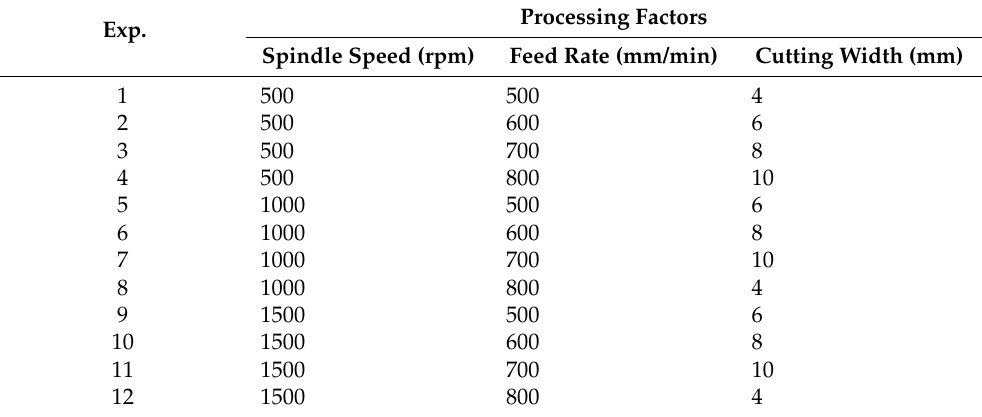
Table 5. Two-factors/four-levels and one-factor/three-levels L 12 and NHC core specimens.